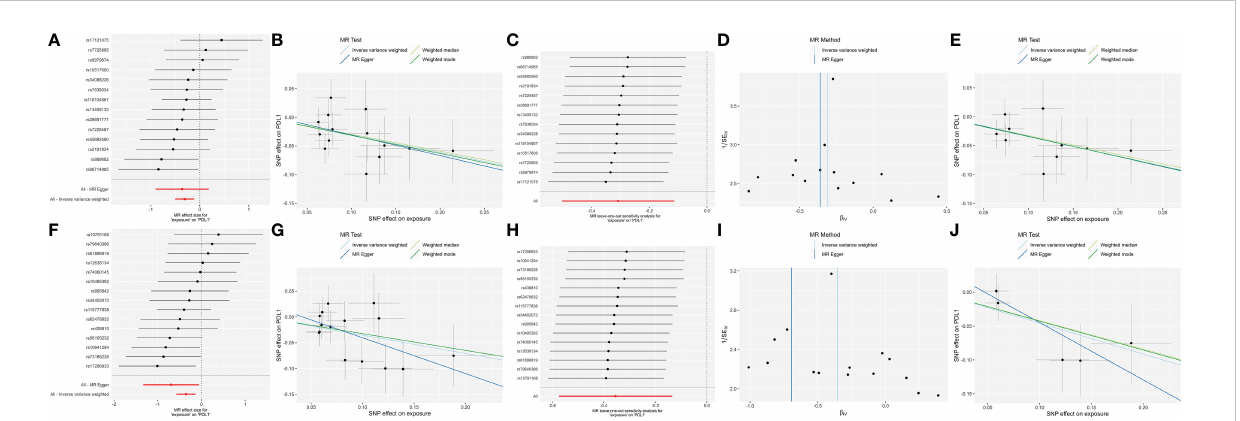
FIGURE 3 The signi fi cant (P FDR <0.05) and robust results (Family_ClostridialesvadinBB60group and Genus_RuminococcaceaeUCG014) in forward MR analysis with two different thresholds. Scatter plot of microbe-related SNP effects on PD-L1, with the slope of each line corresponding to the estimated MR effect per method. Vertical and horizontal black lines around each point show the 95% con fi dence interval for each polymorphism exposure association and polymorphism outcome association. Forest plot lists single and combined (IVW and MR egger) SNP MR-estimated effect sizes; the effect estimates represent the b for PD-L1 per one-s.d. increase in mean microbes. The one-sided leave-one-out and symmetric funnel plots meant that the results were stable without outliers. Family_Clostridiales_vadin_BB60_group: (A) Forest plot at the loose threshold. (B) MR scatter at the loose threshold. (C) Leave one out at the loose threshold. (D) Funnel plot at the loose threshold. (E) MR scatter at the strict threshold. Genus_Ruminococcaceae_UCG014: (F) Forest plot at the loose threshold. (G) MR scatter at the loose threshold. (H) Leave one out at the loose threshold. (I) Funnel plot at the loose threshold. (J) MR scatter at the strict